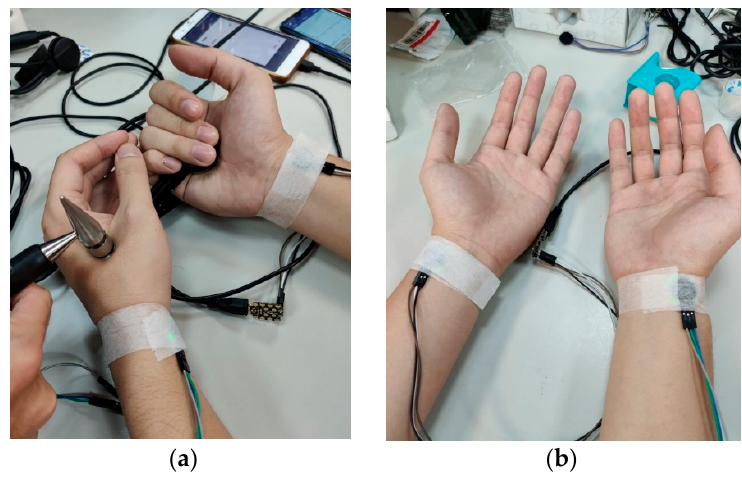
Figure 3. Placement of the ( a ) GSR and ( b ) PPG sensors.